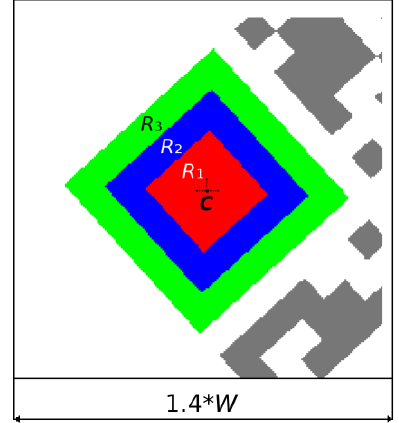
Figure 7. Regions of the Finder Pattern candidate.